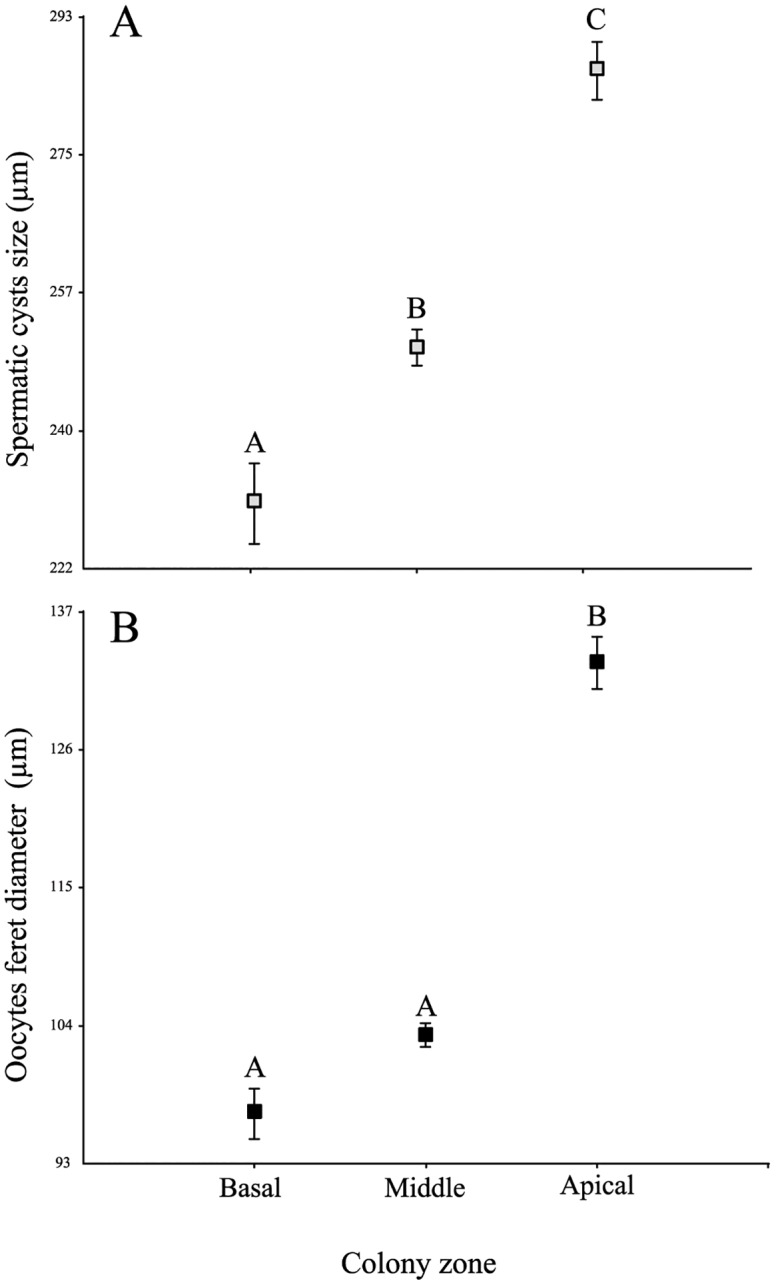
Oocytes and spermatic size distribution.(A) Mean spermatic cyst size (n = 265 basal; n = 1647 middle and n = 790 apical) and (B) oocyte feret diameter distribution in each of the colony sections: basal, middle and apical (n = 645 basal; n = 3801 middle and n = 880 apical). Vertical bars indicate ± SE. Letters indicate groups of the a posterior multiple range test (p< 0.05).